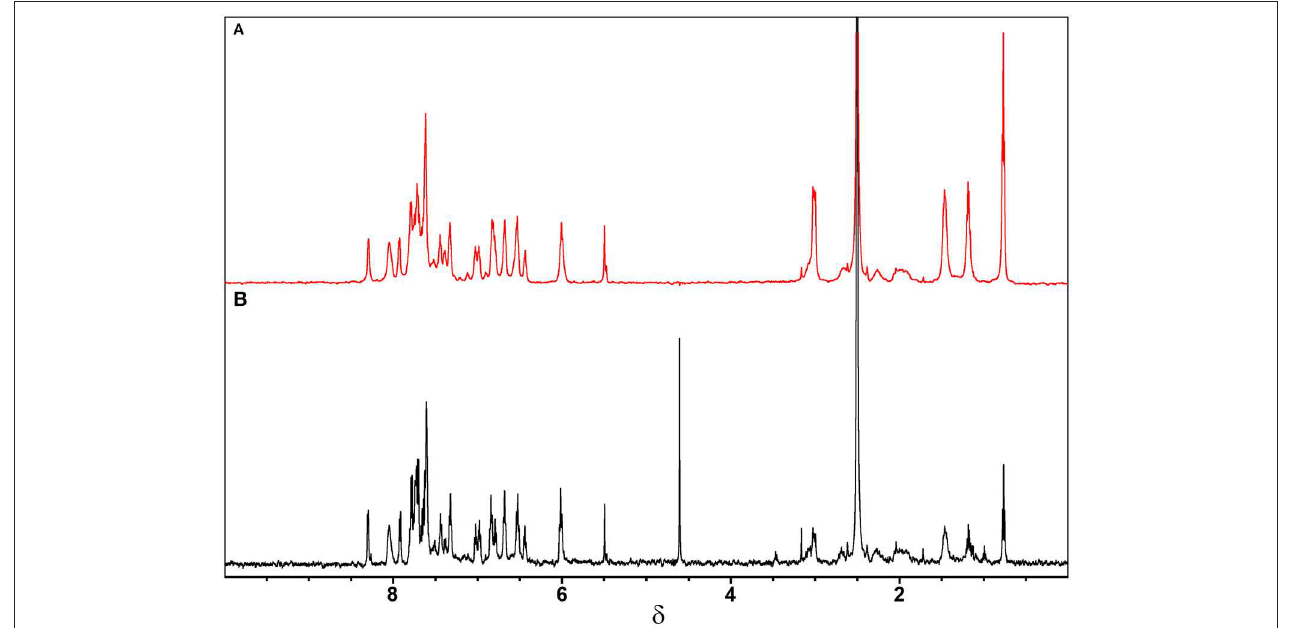
FIGURE 3 | 1 H - NMR spectra obtained for CBLAU (5mM): (A) with (red) and (B) without (black) CT-DNA (50 µ M) at 600 MHz (for 1 H nucleus) and 298K.